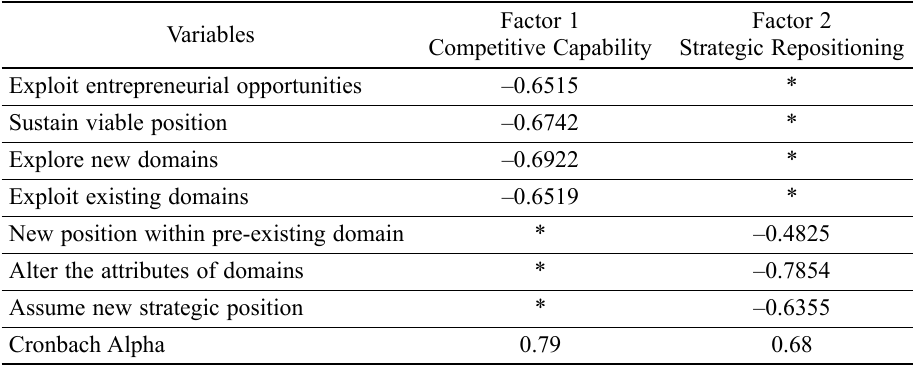
Table 3. Organizational outcome factor loadings after varimax